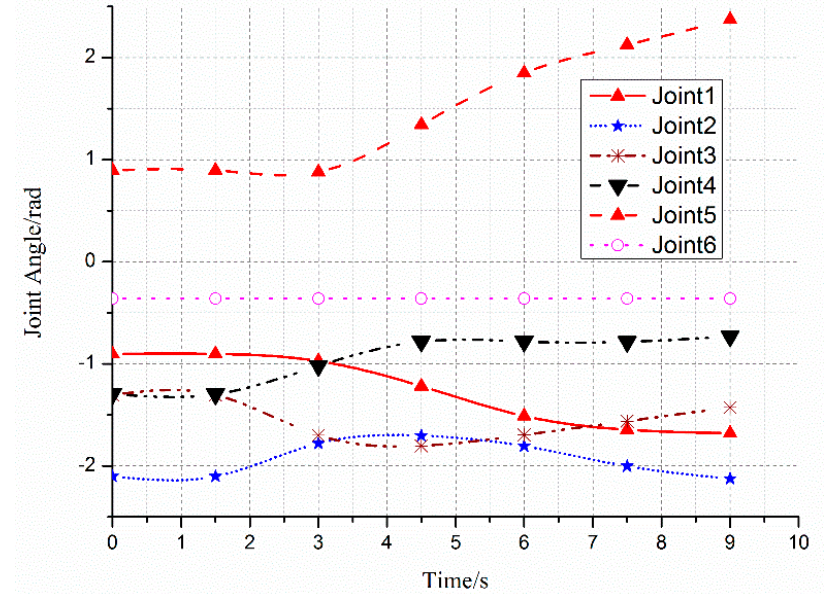
Figure 7. Comparison of the three algorithms and curvature variation with S-RRT. ( a ) Comparison of path planning with the three algorithms; ( b ) Variation of path curvature with path length.